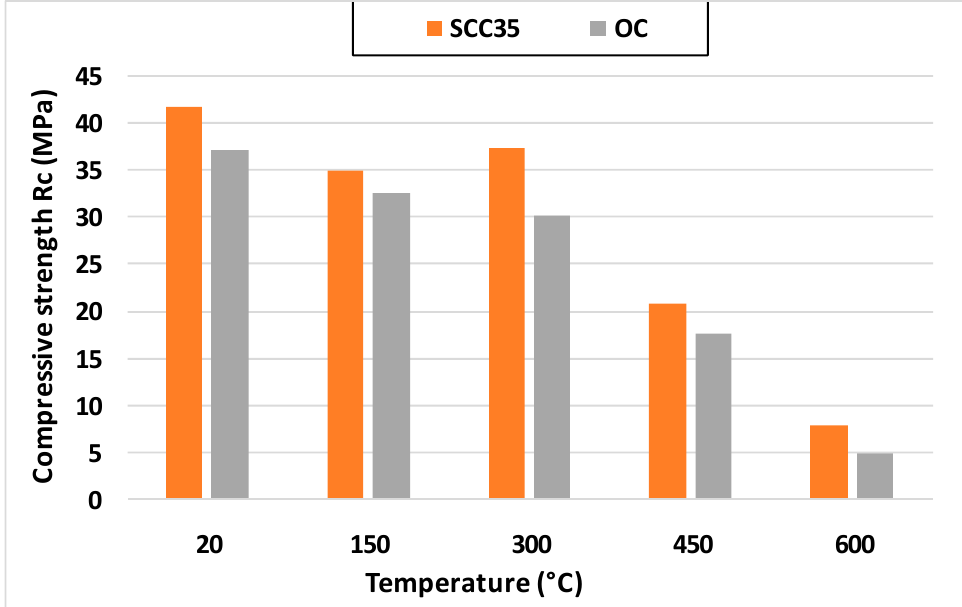
Figure 9. Effect ofthe heating-cooling cycle on the compressive strength.